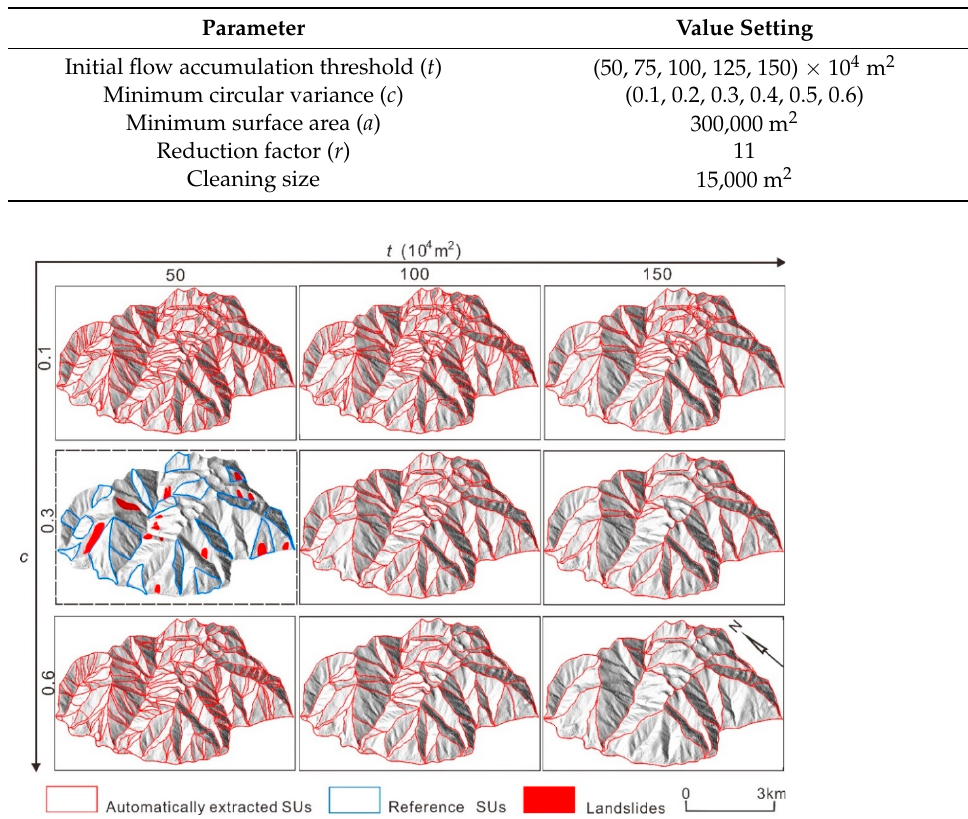
Figure 5. Examples of 9 SU terrain subdivisions for part of the Yuqu River Basin. The blue lines are reference SUs through a semi-automatic hydrological analysis method. Latitude/longitude: 28 ◦ 35 (cid:48) 10 (cid:48)(cid:48) ~28 ◦ 41 (cid:48) 53 (cid:48)(cid:48) , 98 ◦ 24 (cid:48) 11 (cid:48)(cid:48) ~98 ◦ 35 (cid:48) 56 (cid:48)(cid:48)